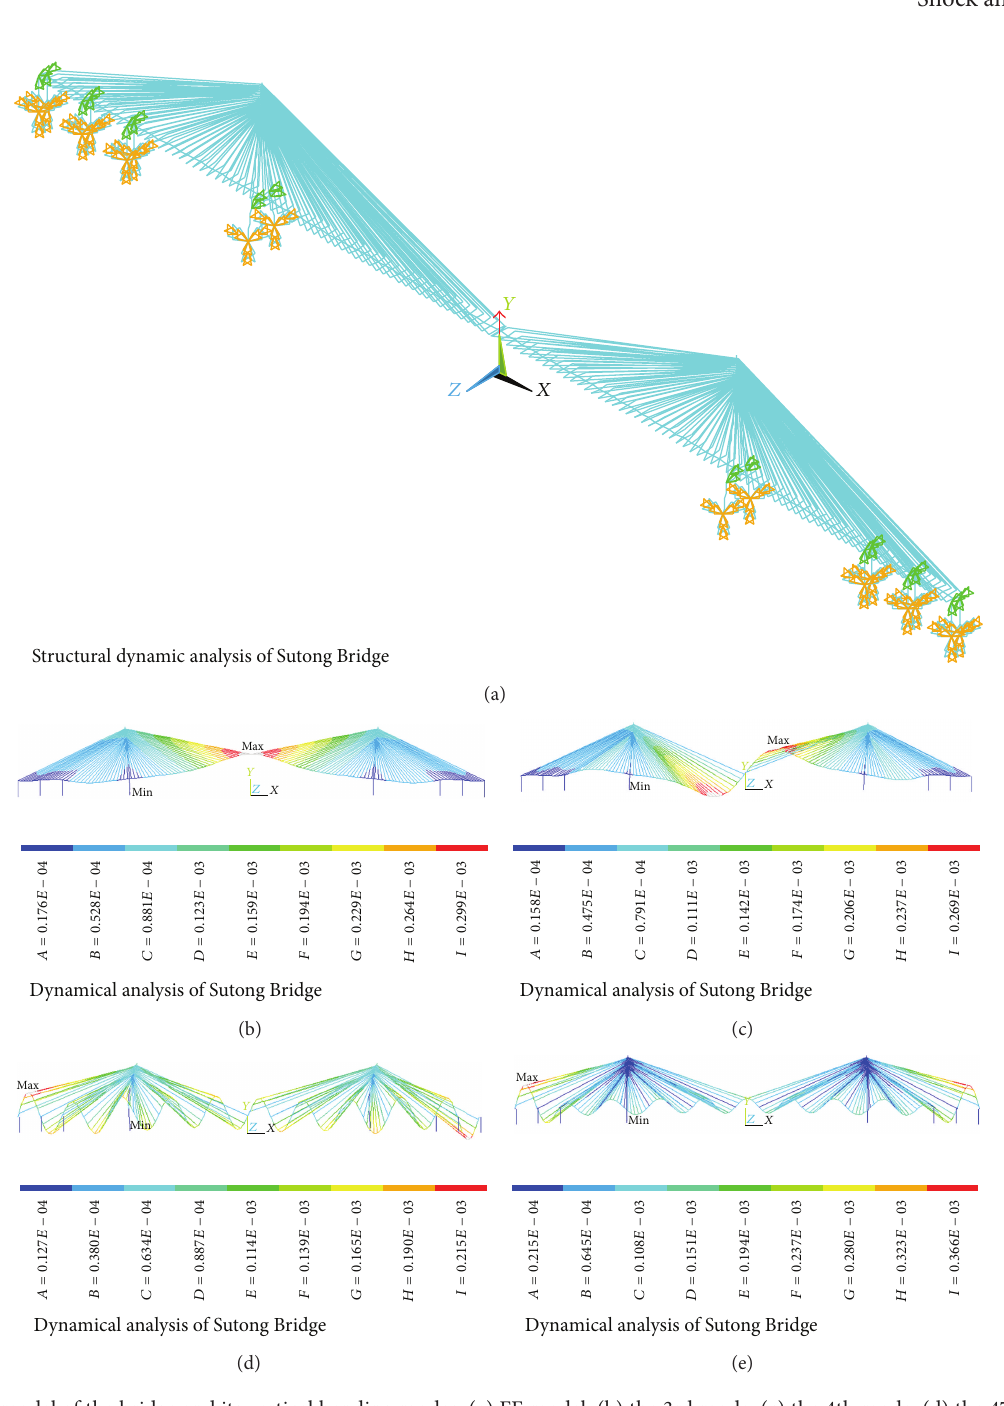
Figure 2: FE model of the bridge and its vertical bending modes: (a) FE model; (b) the 3rd mode; (c) the 4th mode; (d) the 47th mode; (e) the 48th